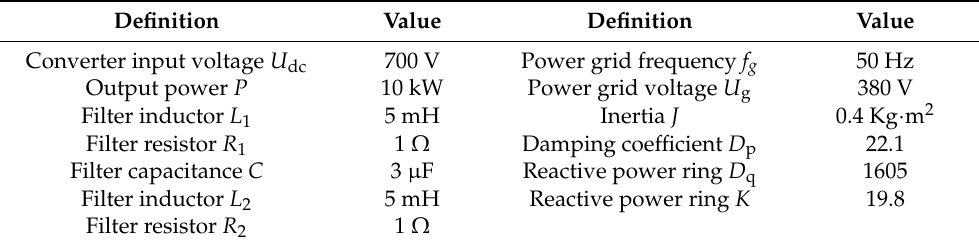
Table 2. System parameters of three-phase LCL Filter grid-connected